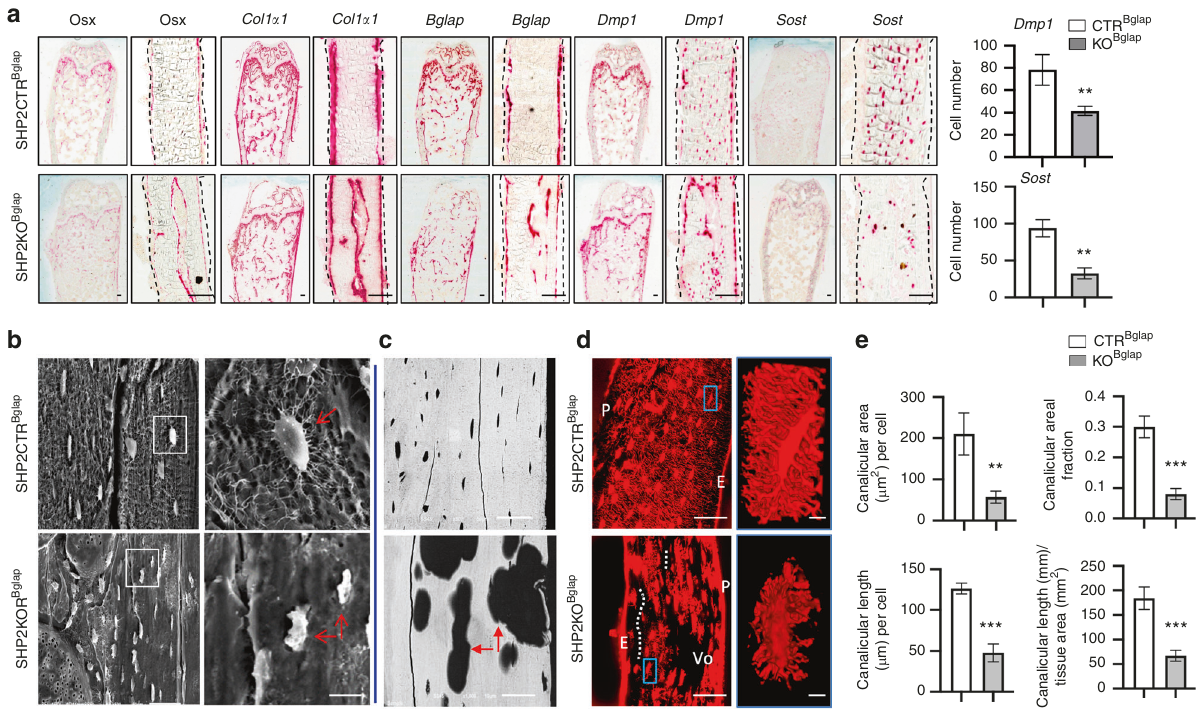
Fig. 3 SHP2 regulates osteoblast maturation and function. a Images of femoral frozen sections show the transcript abundance of the indicated osteoblastic genes determined using RNAScope ® assays (low-power images shown in Fig. S4a). Dmp1 - and Sost -positive cells were quanti fi ed from the selected areas (500 × 200 μ m) of the central diaphyseal cortical bone from the control and SHP2 mutants. Areas selected for enlarged view are shown in Fig. S4a. The quanti fi ed data are shown by bar graphs on the right ( n = 3, ** P < 0.01, Student ’ s t -test). Acid etching ( b ) and back-scattered SEM ( c ) images of the femoral cortical bone show the microarchitecture of osteocytes in 13-week-old mice with the indicated genotypes. Enlarged views of the boxed areas in b and d are shown in the right panel of each fi gure. Arrow, osteocytes, unmineralized matrix. d Confocal imaging showed a disorganized osteocyte lacunar – canalicular system (LCS, red) with disrupted areas (indicated by dotted lines and Vo) in the humeral cortex of 13-week-old mouse mutants. Enlarged views of the boxed areas are shown on the right. E endosteum, P periosteum, Vo void without canaliculi. e Impaired canalicular network (area or length per cell or per unit tissue) in mutants ( n = 4, ** P < 0.01, *** P < 0.001, Student ’ s t -test). Scale bar: a 100 μ m; b 50 μ m; c 50 μ m; d 50 μ m (left); 3 μ m